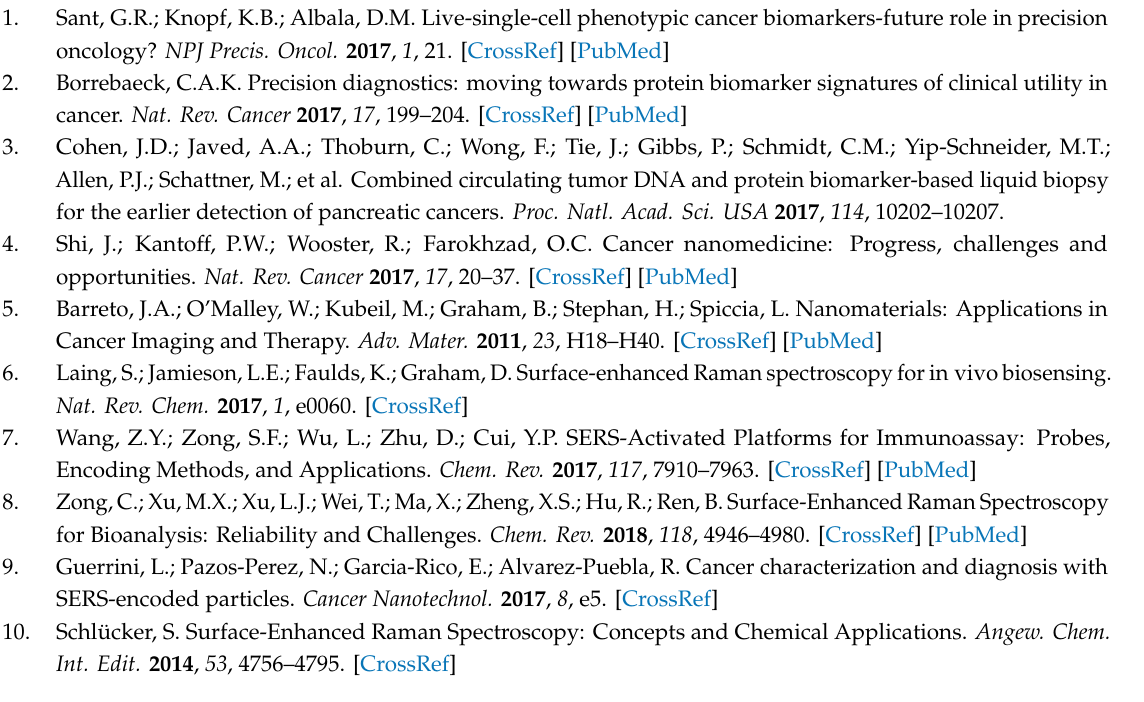
Table S1: Examples of SEPs employed in cancer research classified according to the plasmonic core geometry. Author Contributions: L.G. and R.A.A.-P. wrote the review and designed the figures. Funding: This work was funded by the Spanish Ministerio de Economia, Industria y Competitividad (CTQ2017-88648R and RYC-2016-20331), the Generalitat de Catalunya (2017SGR883), the Universitat Rovira I Virgili (2018PFR-URV-B2-02), and the Universitat Rovira I Virgili and Banco Santander (2017EXIT-08). Conflicts of Interest: The authors declare no conflict of